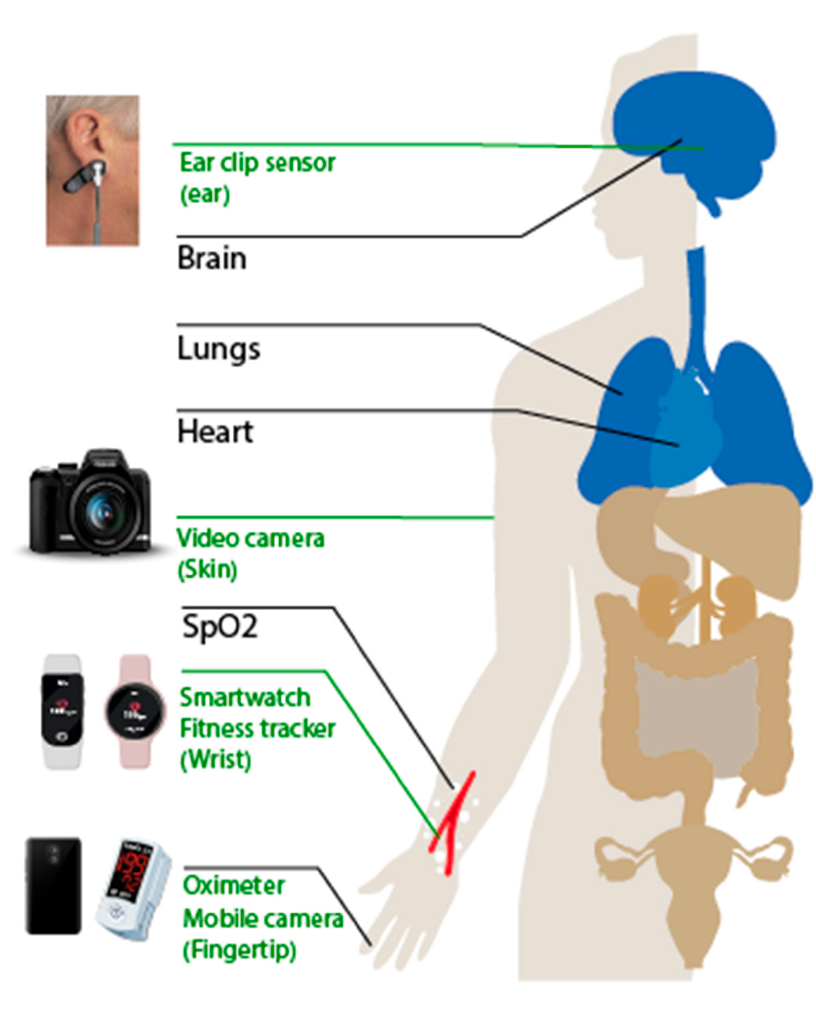
Figure 4. Different human organs affecting the PPG signal together with acquisition setups.